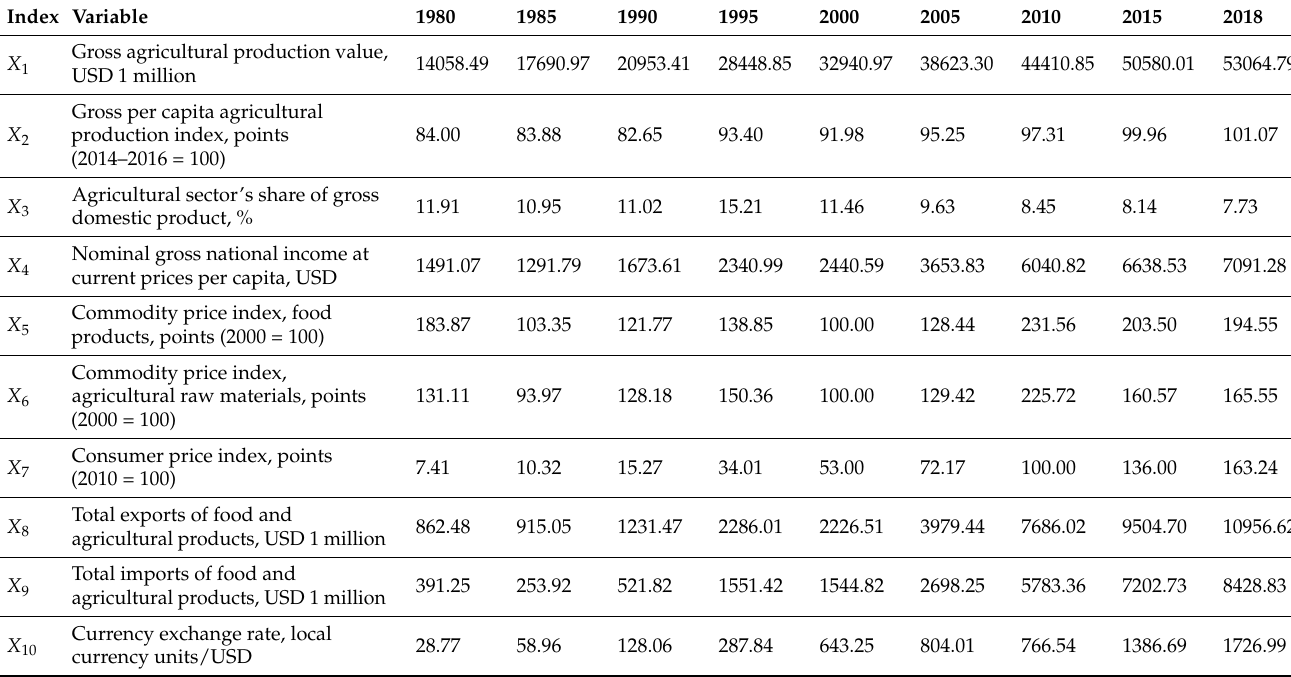
Table A6. Regressors ( X n ) in upper-middle-income economies, averaged values,